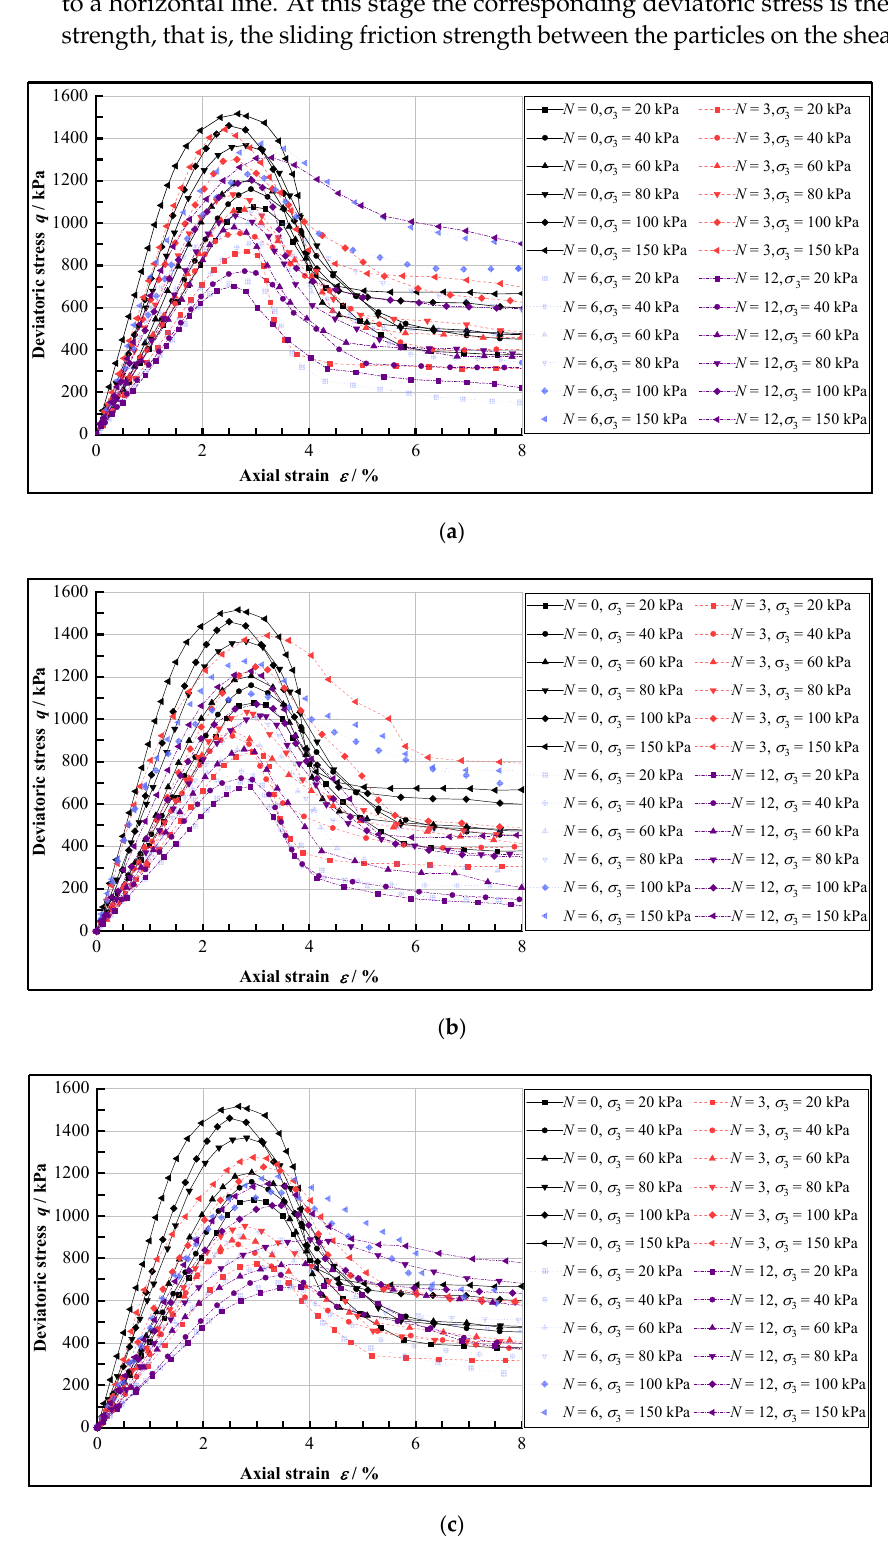
Figure 2. The stress-strain curves of CIL under different freezing temperatures, ( a ) The freezing condition of −5 °C, ( b ) The freezing condition of −10 °C, ( c ) The freezing condition of −15 °C.